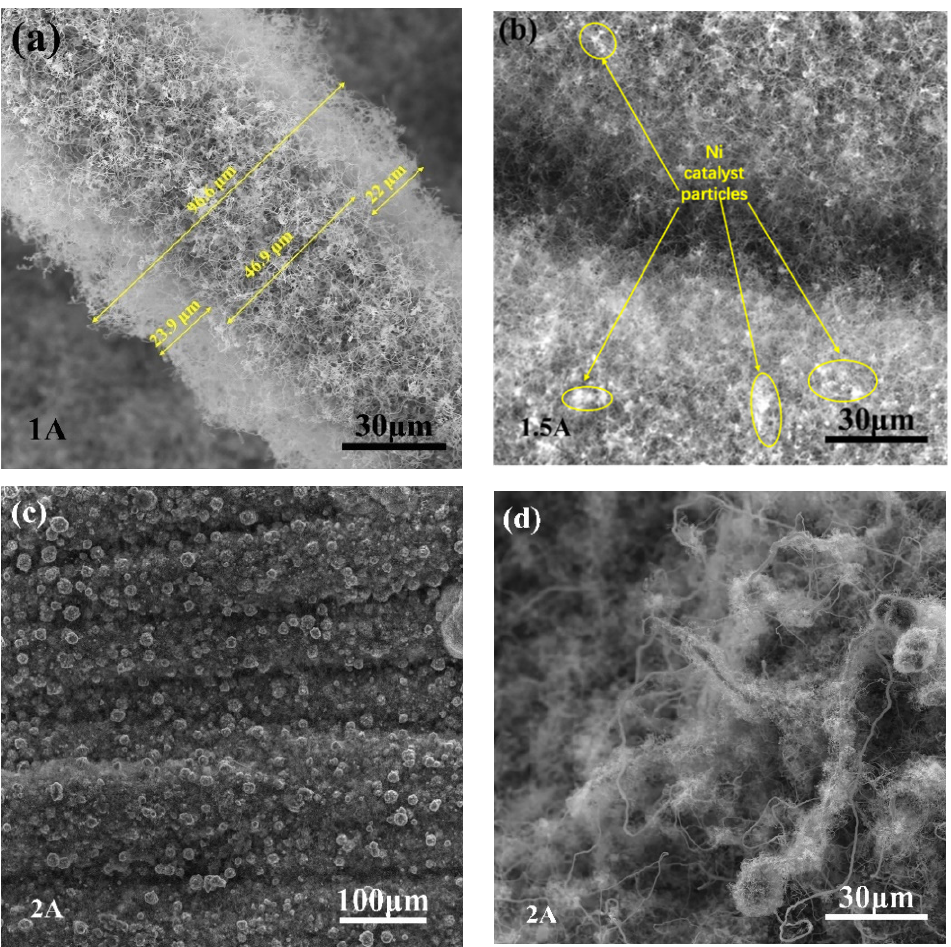
Figure 2. Microstructures of SiCNWs grown via EP with electroplating currents of ( a ) 1 A, ( b ) 1.5 A, and ( c , d ) 2 A.